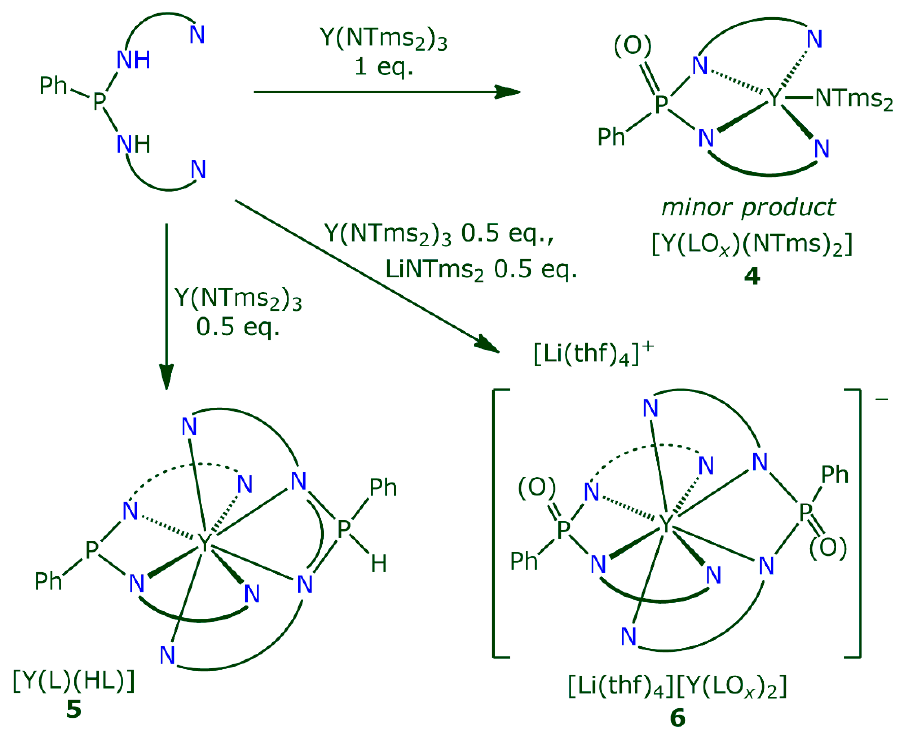
Scheme 3. Reactions of H 2 L with Y(NTms 2 ) 3 . Top: in the ratio of 1:1, with the formation of [Y(PhPO x (NBtd) 2 )NTms 2 ] ( 4 ). Bottom left: in the ratio L:Y = 2:1, with the formation of [YL(HL)] ( 5 ). Bottom right: in the ratio L:Y:Li = 2:1:1, with the formation of [Li(thf) 4 ][Y(PhPO x (NBtd) 2 ) 2 ] ( 6 ).